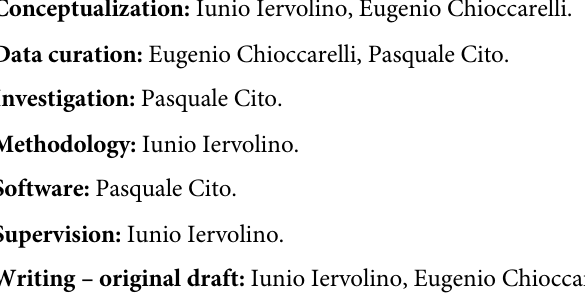
S3 Table. Exceedances of MPS04 thresholds. Details of the exceedances, at the station sites, of the ground motion intensity measure thresholds associated to MPS04. S4 Table. Exceedances of MPS19 thresholds. Details of the exceedances, at the station sites, of the ground motion intensity measure thresholds associated to MPS19. S5 Table. Exceedances of ESHM20 thresholds. Details of the exceedances, at the station sites, of the ground motion intensity measure thresholds associated to